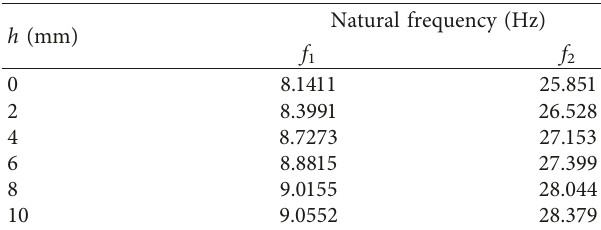
Figure 5: Variations of the natural frequencies with a central ellipse cutout of different shapes. Table 3: Influence of flanging height on the first two frequencies of clamped-free